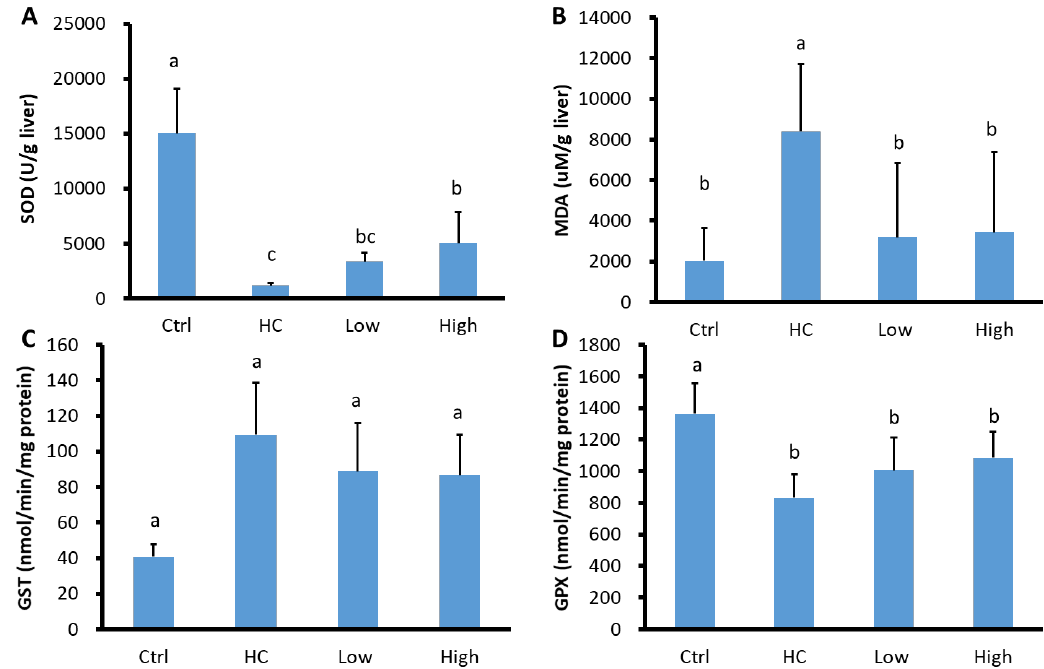
Figure 1. Hepatic prooxidant-antioxidant status in di ff erent groups. ( A ) Antioxidant superoxide dismutase (SOD) level; ( B ) the prooxidant index level of malondialdehyde (MDA); ( C ) the antioxidant glutathione S-transferase (GST) level; ( D ) the antioxidant glutathione peroxidase (GPx) level. Ctrl: control group; HC: HC group; Low: low-dose HC + HO group; High: high-dose HC + HO group. Letters a, b, and c indicate that a significant di ff erence was detected by one-way ANOVA with Duncan’s multiple range